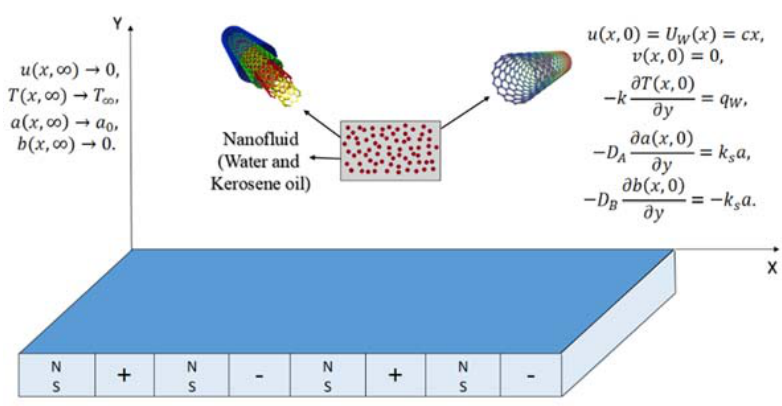
Figure 1. Schematic diagram.